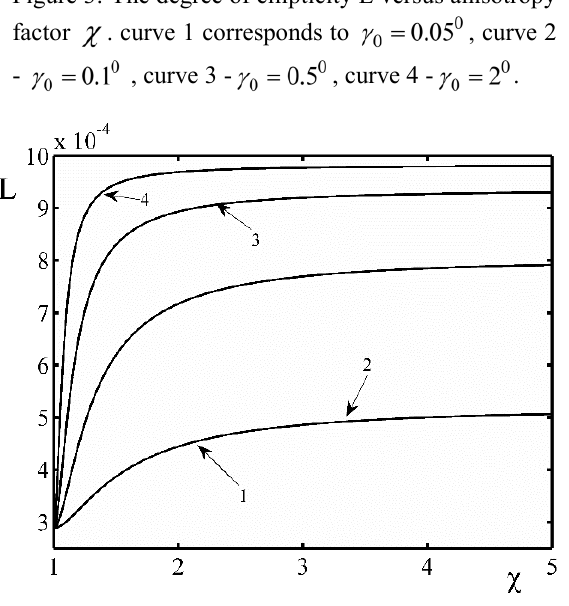
Figure 4: The degree of linear polarization L versus anisotropy factor . Curve 1 corresponds to , curve 2 - , curve 3 - , curve 4